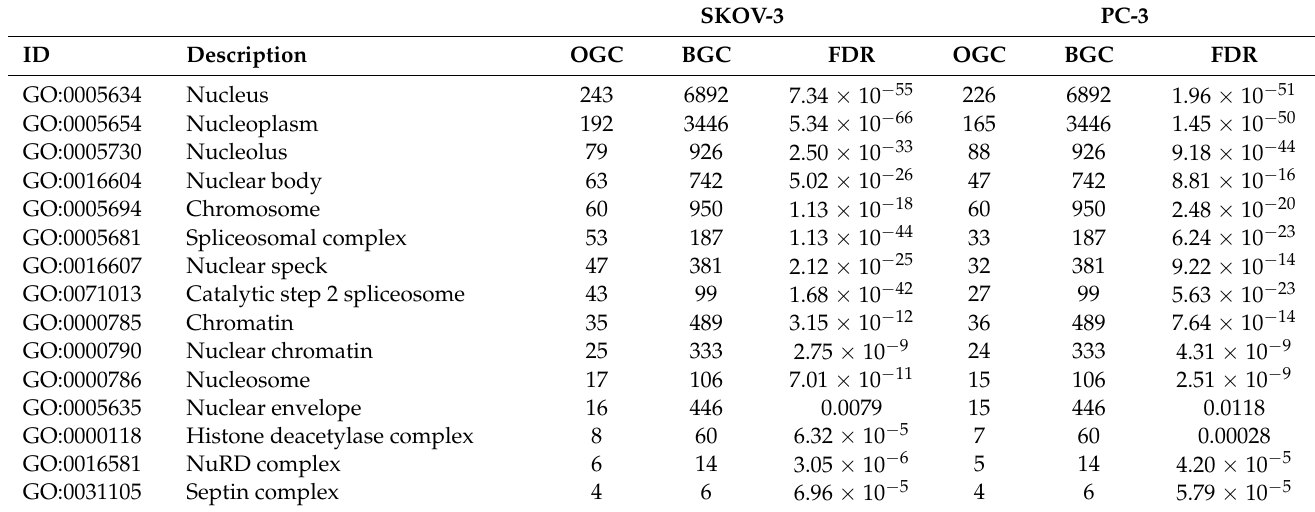
Figure 5. Differential expression of genes related to RNA processing in tumours expressing HMGB1 at high or low levels. ( A ) Selection of samples expressing mRNA HMGB1 at levels > median + 1.5 SD (HMGB1-high) and samples expressing mRNA HMGB1 at levels < median − 1.5 SD (HMGB1-low). ( B ) Volcano plots of genes expressing at higher levels in each group; log ratio in HMGB1-high/HMGB1-low. Ov, samples obtained from the PanCancer ovarian cystadenocarcinoma ATCG study in cBioportal; Pr, samples obtained from the PanCancer prostate adenocarcinoma ATCG study in cBioportal. ( C ) GO term enrichment analysis of genes expressed at higher levels in HMGB1-high samples in ovary or prostate cancer. Table 3. GO-term enrichment analysis of the nuclear compartment distribution of HMGB1-nuclear interactomes in SKOV-3 and PC-3 cells. (OGC, observed gene count; BCG, background gene count; FDR, false discovery